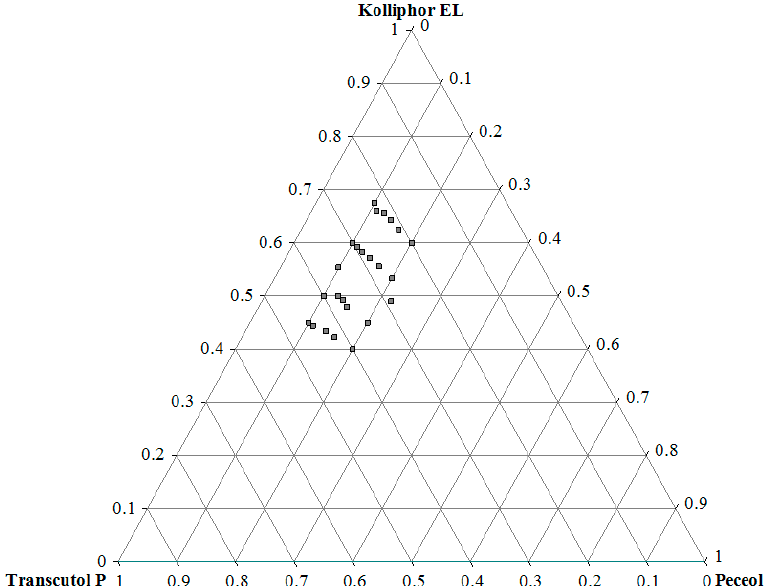
Figure 3. Ternary phase diagram of Peceol ® , Kolliphor ® EL, and Transcutol ® P based on droplet size and transmittance analysis. The area bordered by grey squares represents the self-nanoemulsifying region. (n = 3).